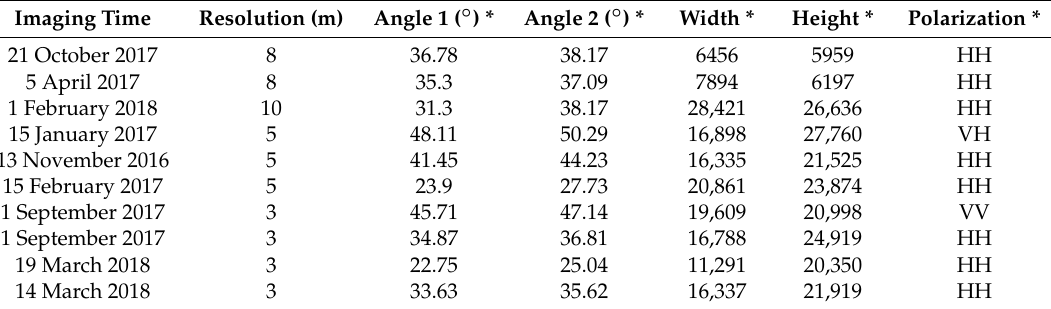
Table 1. The detailed information for several Chinese Gaofen-3 SAR images. Imaging